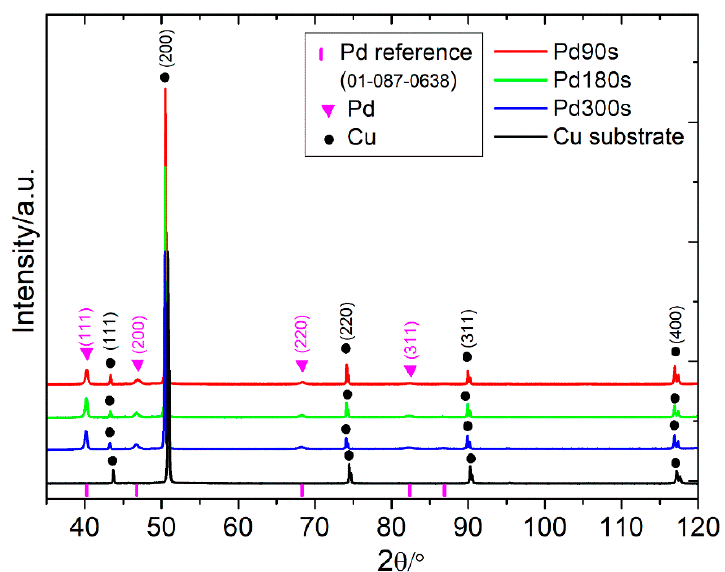
Figure 3. Diffractogram of the different Pd samples obtained by DHBT. The black curve shows the diffractogram of the copper substrate alone.